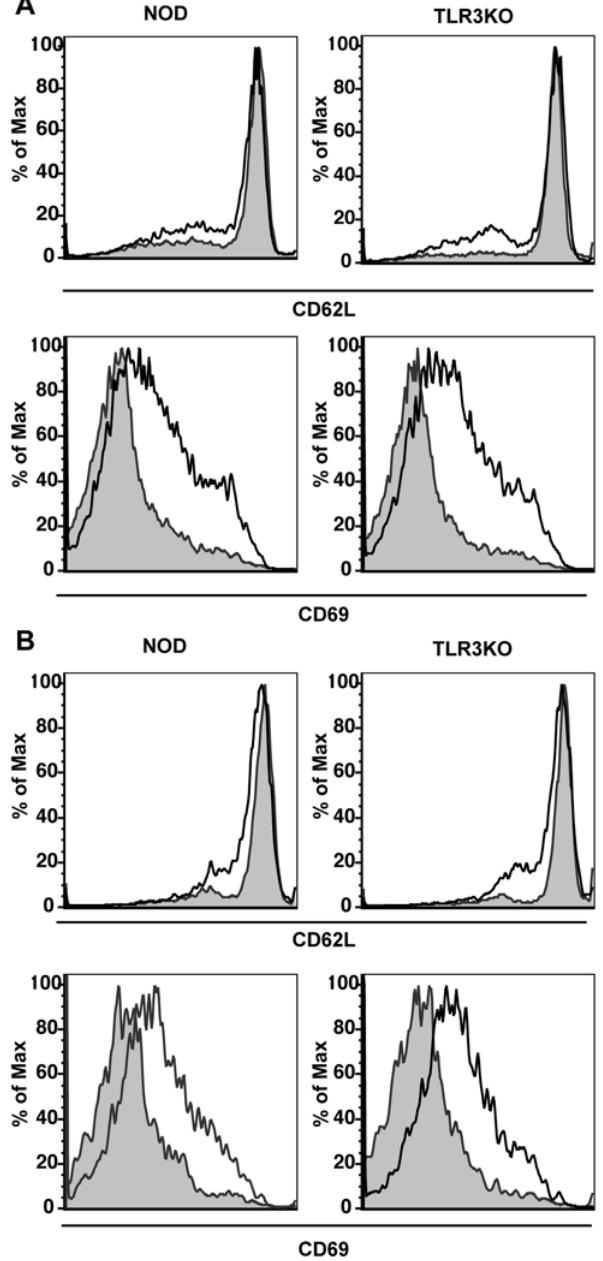
Figure 3. TLR3 deficiency does not affect the capacity of innate effectors to activate following CB4 infection. Representative histograms of CD69 expression on (A) NK (Pan-NK + , TCR b 2 ) or (B) NK T cells (Pan-NK + , TCR b + ) from WT NOD (left panels) and TLR3KO (right panels) mice at 48 hours post-infection with 400 pfu of CB4 (solid black lines) or mock-infection with DMEM (shaded histogram). Representative histograms of CD80 expression on the surface of (C) macrophages (CD11b + CD11c 2 ) and (D) dendritic cells (CD11c + ) from WT NOD (left panels) and TLR3KO (right panels) mice at 4 days post-infection with 400 pfu of CB4 (solid black lines) or mock-infection with DMEM